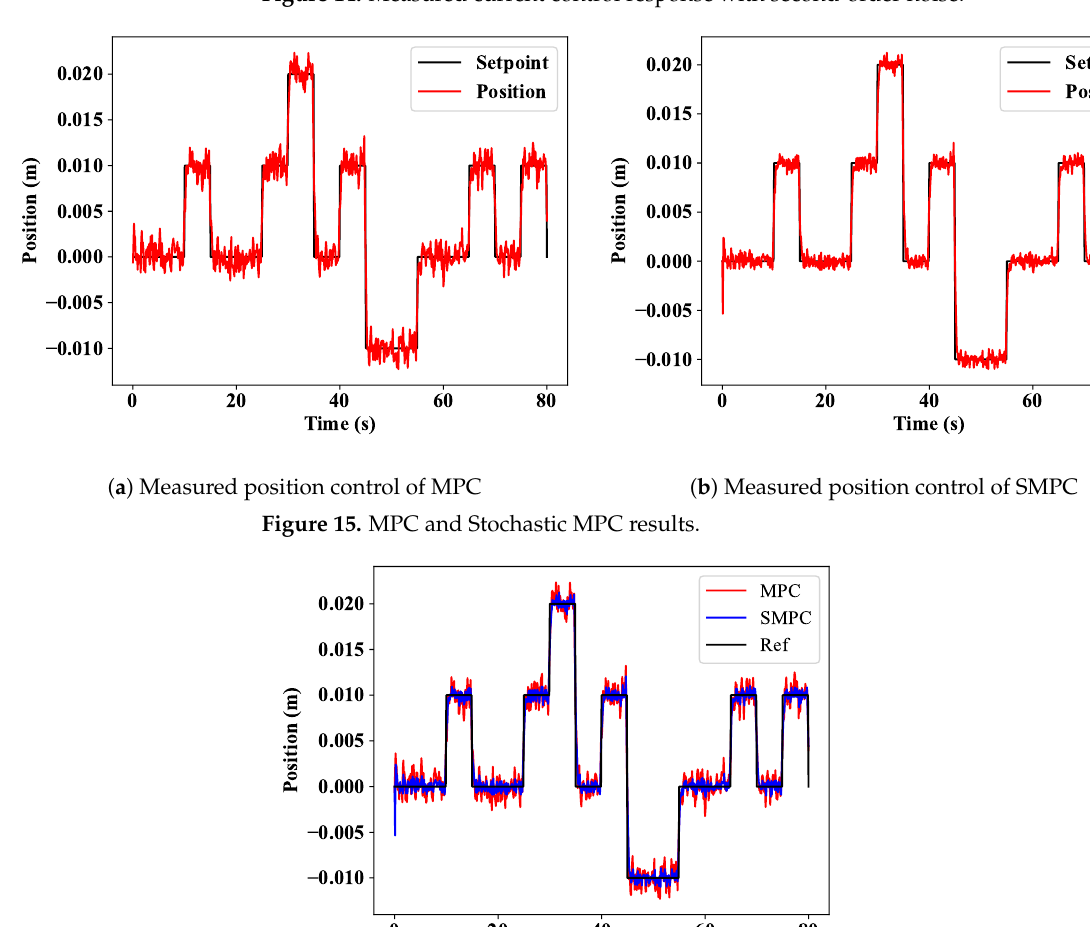
Figure 14. Measured current control response with second-order noise.